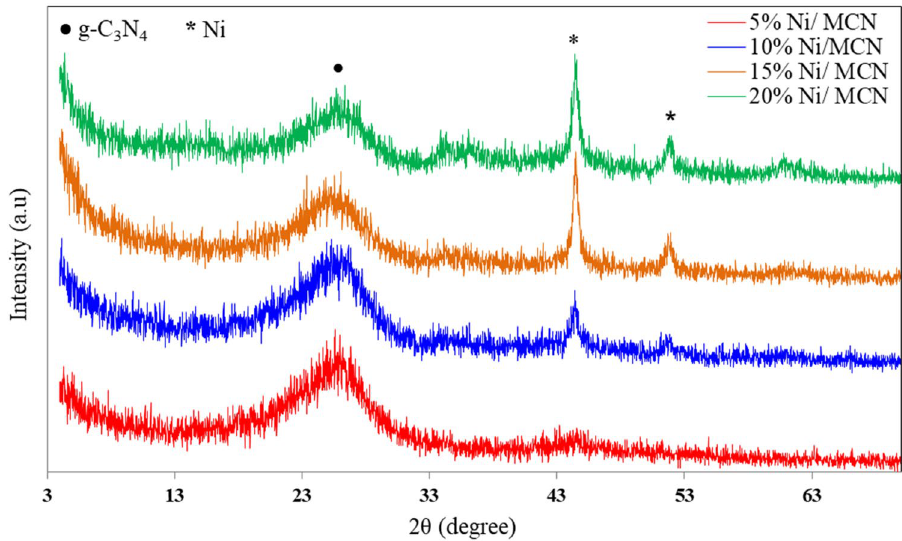
Figure 1. XRD charts of the prepared